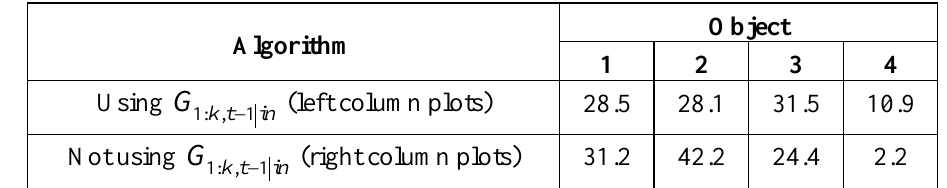
Table 1. Distribution percentage of particles in the set among the tracked hypotheses